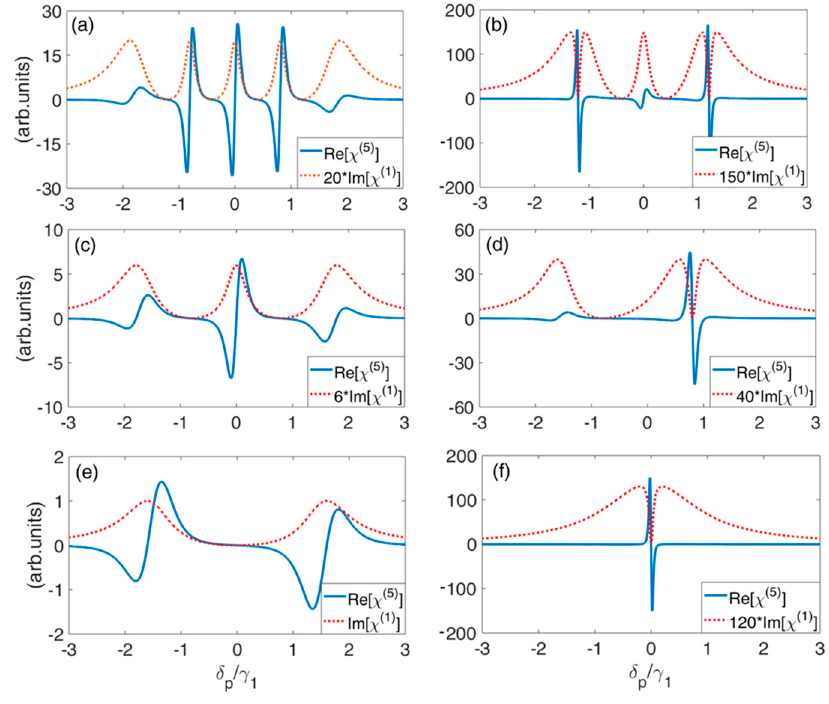
(cid:104) (cid:104) (cid:105) (cid:105) Figure 5. Linear absorption Im χ ( 1 ) χ ( 5 ) and fifth-order nonlinearity Re as a function of probe detuning δ p for varying tunneling coupling and energy splitting. ( a ) ω 12 = − 1.2 γ 1 , ω 13 = − 0.4 γ 1 , ω 14 = 0.4 γ 1 , ω 15 = 1.2 γ 1 , T 3 = T 4 = 0.8 γ 1 , T 2 = T 5 = 0.8 γ 1 ; ( b ) the parameters are the same as those in ( a ), except T 2 = T 5 = 0.2 γ 1 ; ( c ) ω 12 = ω 13 = − 0.8 γ 1 , ω 14 = ω 15 = 0.8 γ 1 , T 2 = T 3 = 0.8 γ 1 , T 4 = T 5 = 0.8 γ 1 ; ( d ) the parameters are the same as those in ( c ), except T 4 = T 5 = 0.2 γ 1 ; ( e ) ω 12 = ω 13 = ω 14 = ω 15 = 0, T 2 = T 3 = T 4 = T 5 = 0.8 γ 1 ; ( f ) the parameters are the same as those in ( e ), except T 2 = T 3 = T 4 = T 5 = 0.1 γ 1 . The other parameters are γ 2 = γ 3 = γ 4 = γ 5 = 10 − 3 γ 1